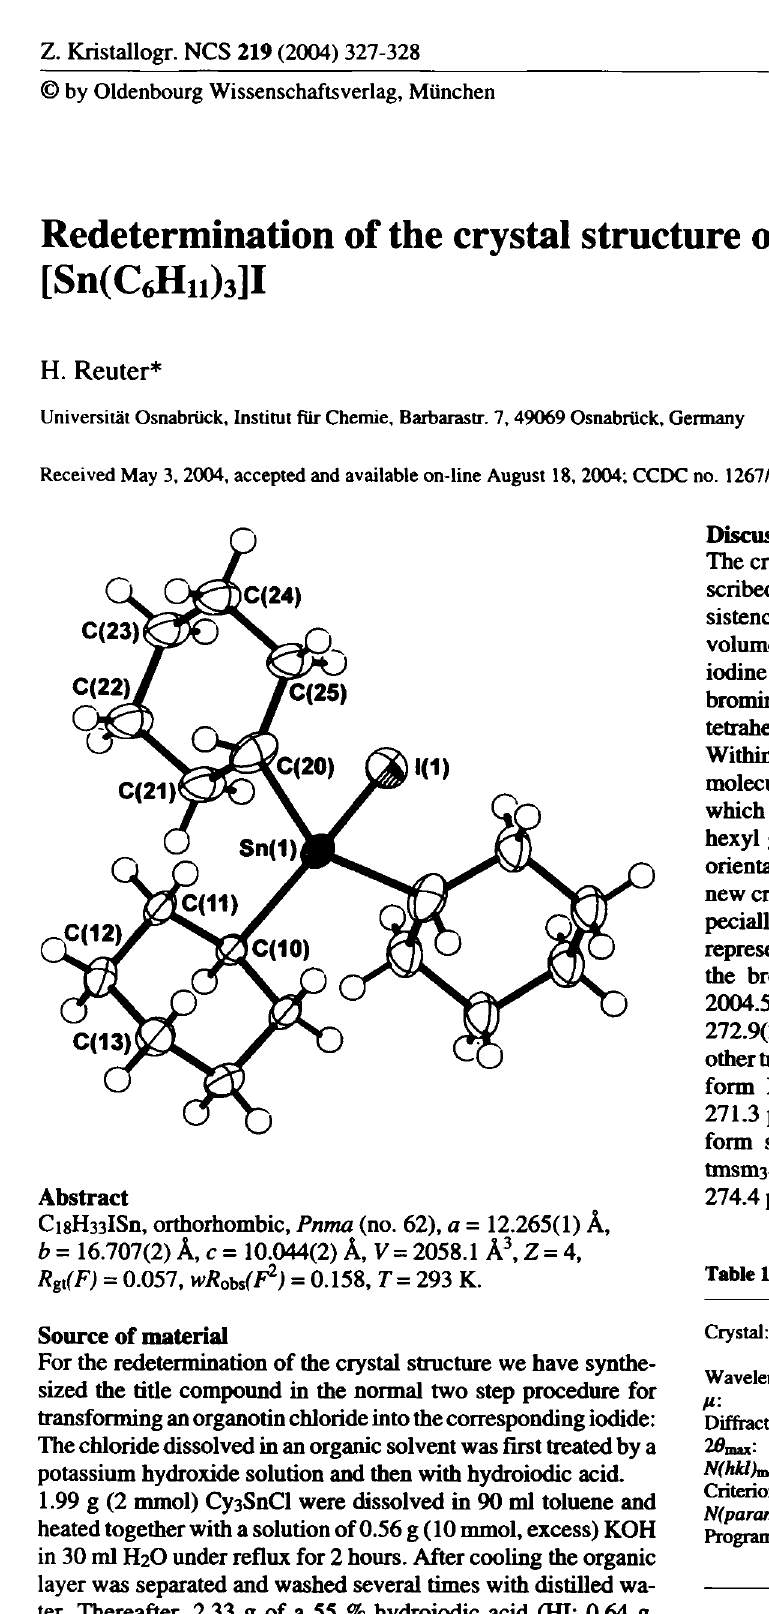
Table 2. Atomic coordinates and displacement parameters (in A 2